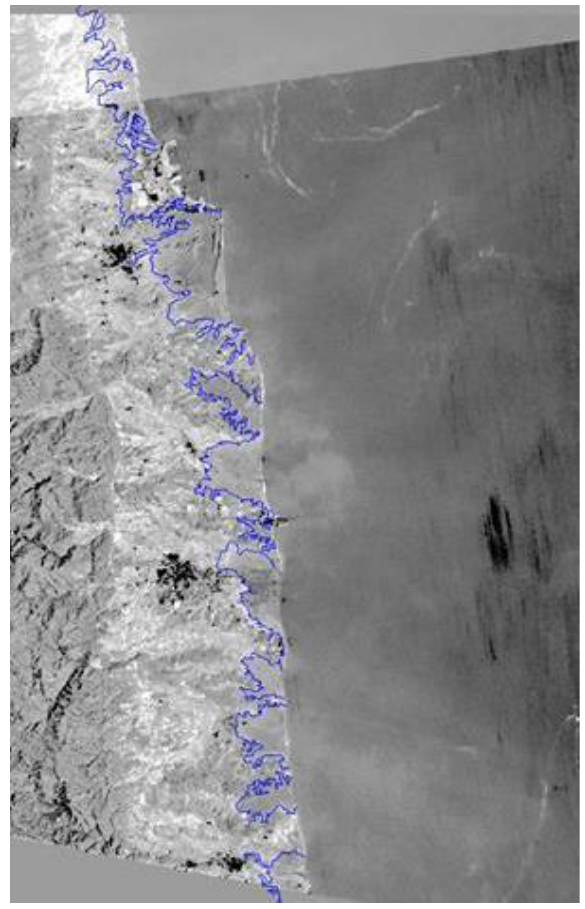
Figure3. Morphological profiles (MPs) 9by9